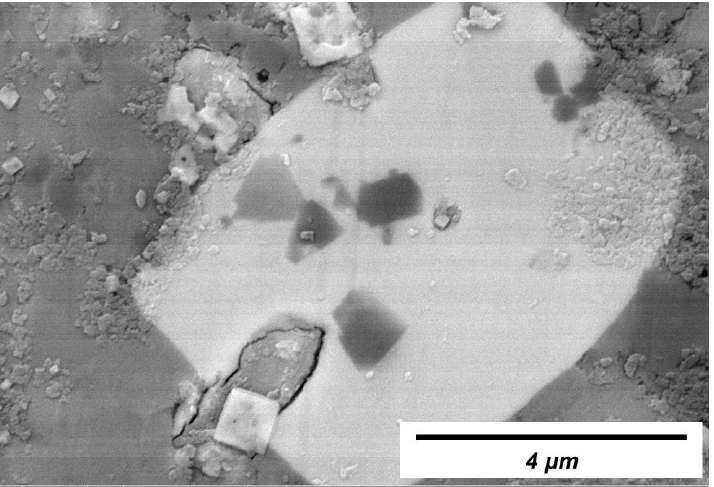
Figure 11. A typical crystal (BaAl 2 O 4 ) precipitated using initial crystals as nuclei (backscattered image, the No. 3 slag film solidified in molten slag at 1300 °C).